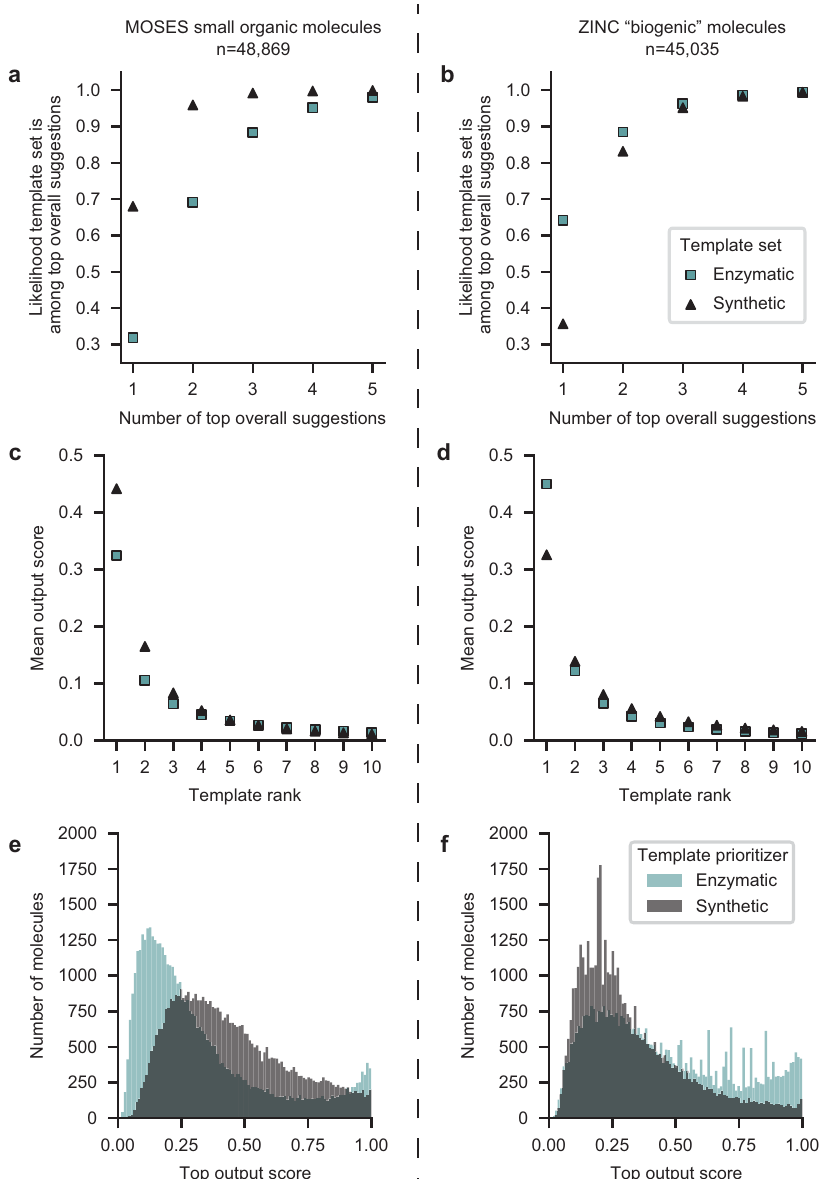
Fig. 4 | Distribution of output scores from the synthetic chemistry and enzy- matic one-step retrosynthesis models. Comparison of predicted output scores (probabilities) from the synthetic chemistry and enzymatic template prioritizers illustratetheirbalancefordifferentchemicalspaces.Thelikelihoodthatatleastone syntheticchemistrytemplate(black)orenzymatictemplate(blue)willrankamong thetoptemplateswhentemplatesfrombothsetsarecombinedandsortedbytheir